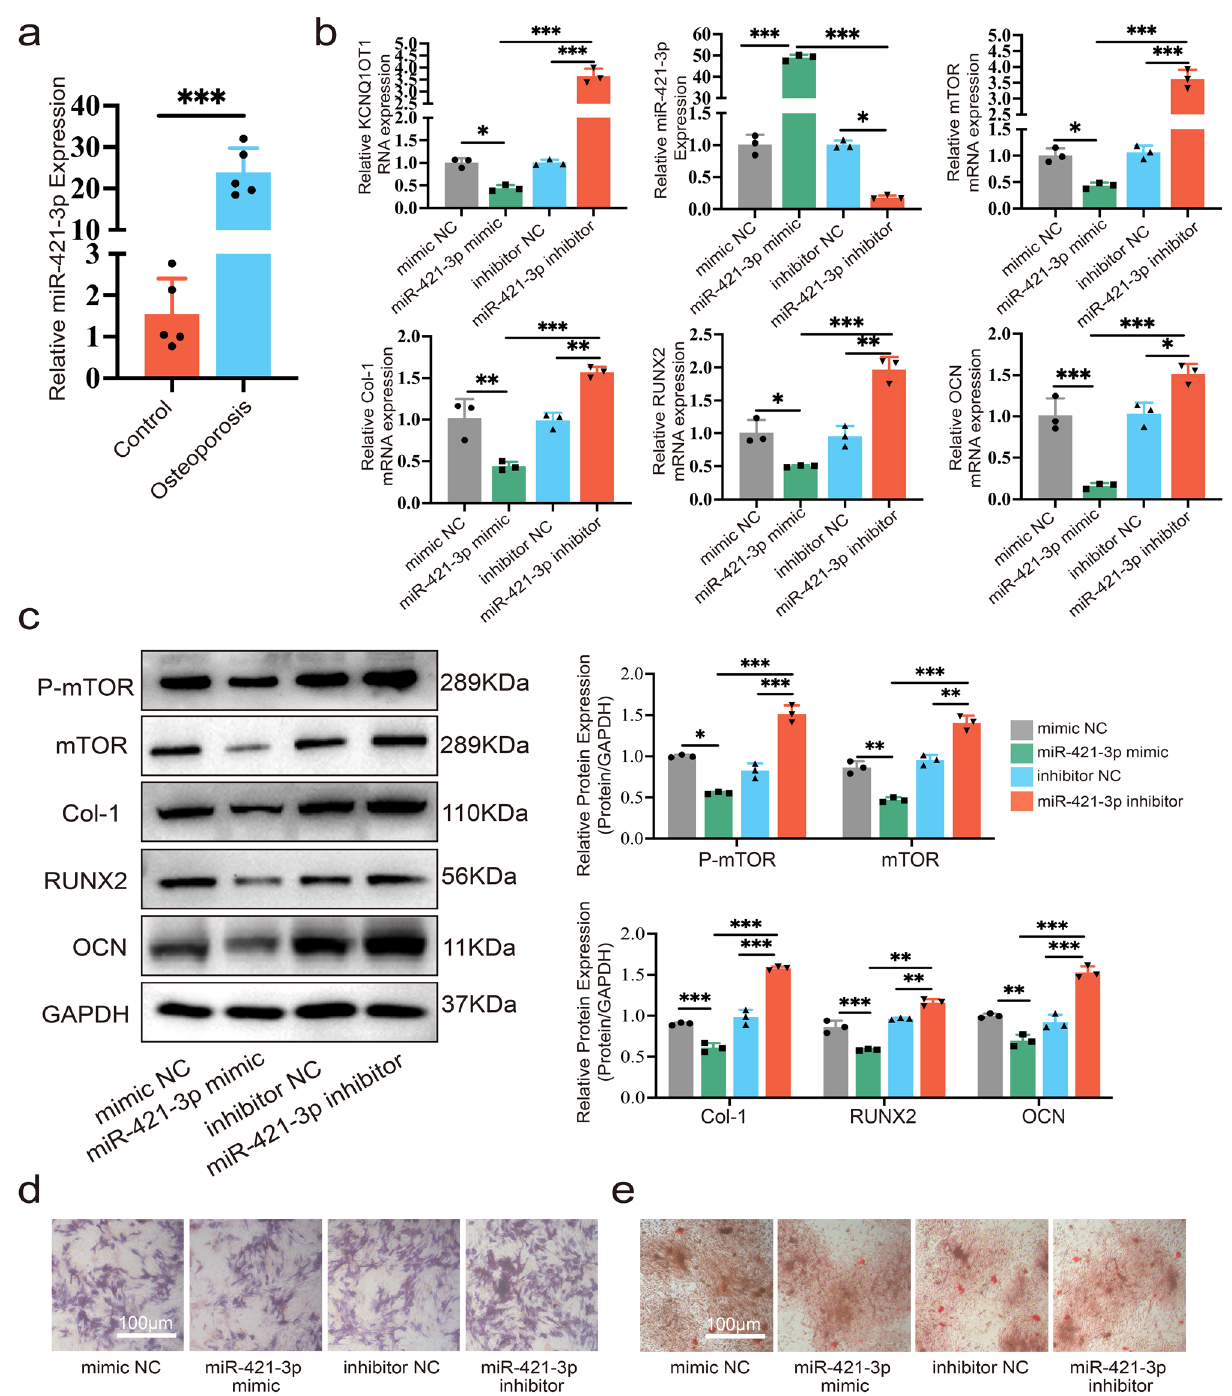
Figure 4. miR-421-3p suppresses MC3T3-E1 cells’ osteogenic differentiation. MC3T3-E1 cells were transfected with miR-421-3p mimic, mimic NC, miR-421-3p inhibitor or inhibitor NC, respectively. ( a ) Relative expression of miR-421-3p in bone tissue of PMOP patients and controls without osteoporosis was performed by qRT-PCR (N = 5). ( b ) RNA expression of Col-1, OCN, RUNX2, KCNQ1OT1, miR-421-3p and mTOR was tested by qRT- PCR. ( c ) Protein expression levels of pmTOR, mTOR, Col-1, RUNX2 and OCN were analyzed by Western blot after transfection and osteogenic differentiation for seven days. Uncropped Western blot images are shown in Supplementary Fig. 6. ( d ) ALP staining showed ALP levels of MC3T3-E1 cells after transfection and osteogenic differentiation for seven days. ( e ) Alizarin Red staining of MC3T3-E1 cells after transfection and osteogenic differentiation for 14 days. *P < 0.05, **P < 0.01, ***P <